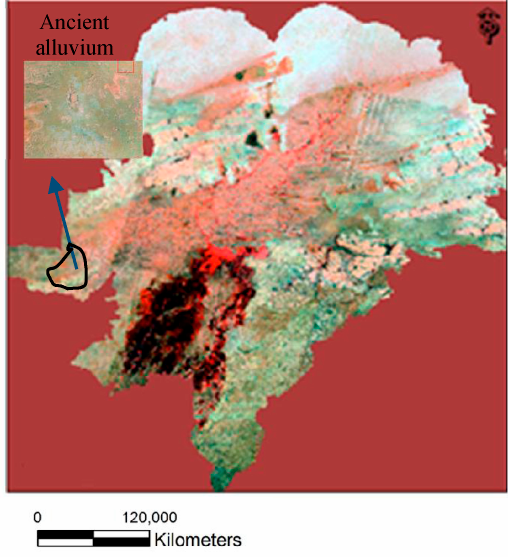
Figure 4. Image RGB obtained with the neo bands generated by the ratios.